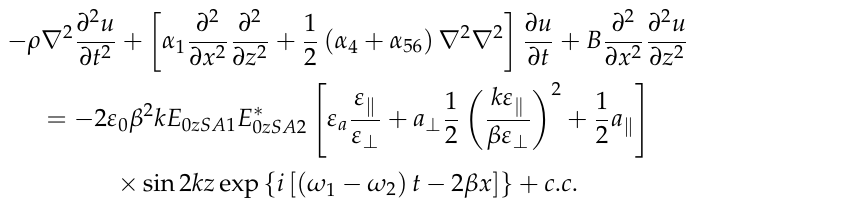
Figure 4. The dependence of normalized wavenumber in the cladding α d for the even modes TM even (curves 1, 3) and odd mode TM odd (curve 2) on the optical 1